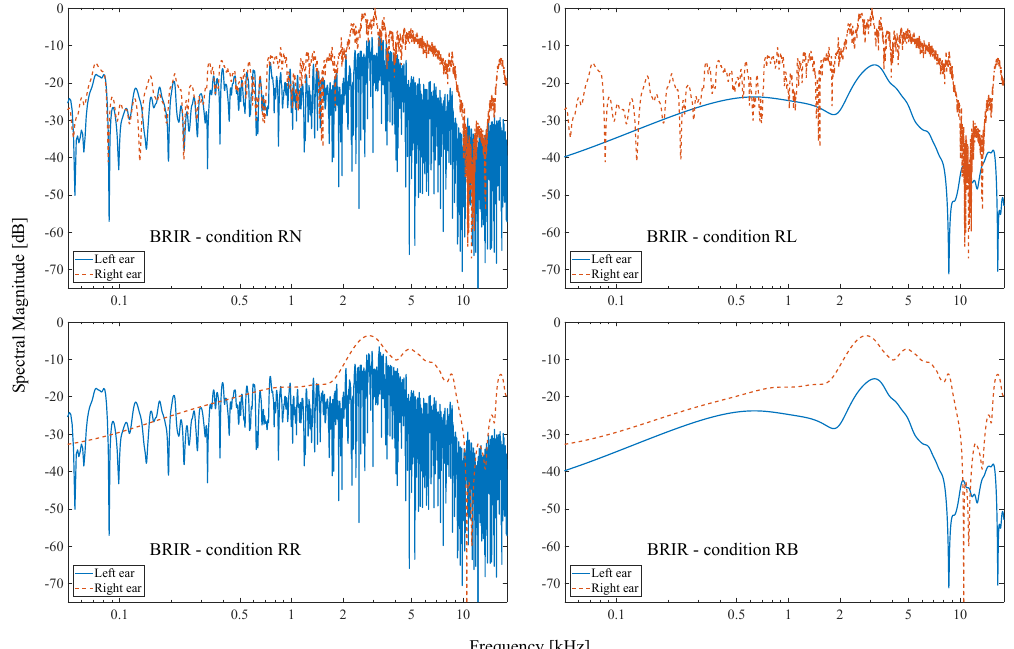
Figure 6. Examples of magnitude spectra for BRIRs with modified reverberant parts at 60° for the “RN” (left top), “RL” (right top), “RR” (left bottom), and “RB” (right bottom) conditions in the frequency domain. The solid and dashed curves denote the magnitude spectra for modified BRIRs of left and right ears,